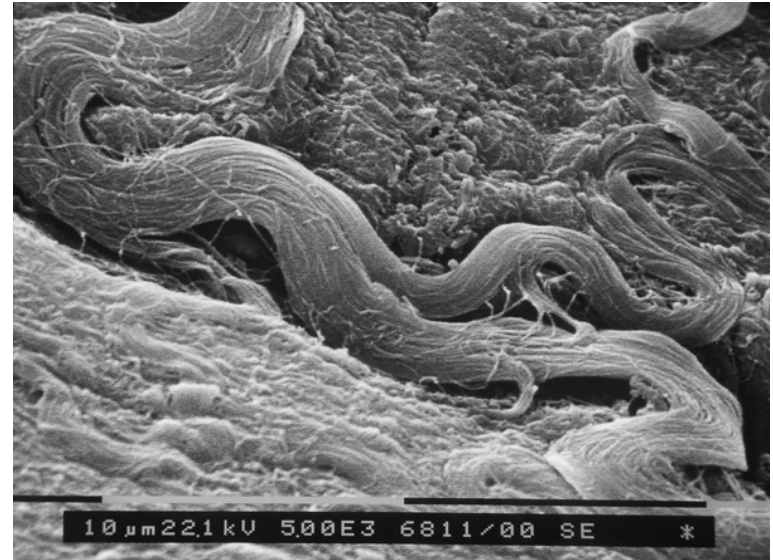
FIGURE 4. SEM image of rat Achilles tendon sheat. No fibrillar crimps are detectable when fibrils change their direction. Bar= 10 μ